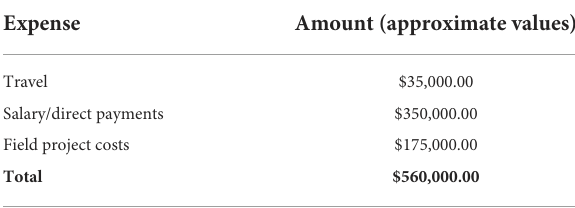
TABLE 5 Total approximate financial spending during the 24-month period of this study including all leveraged funds across three